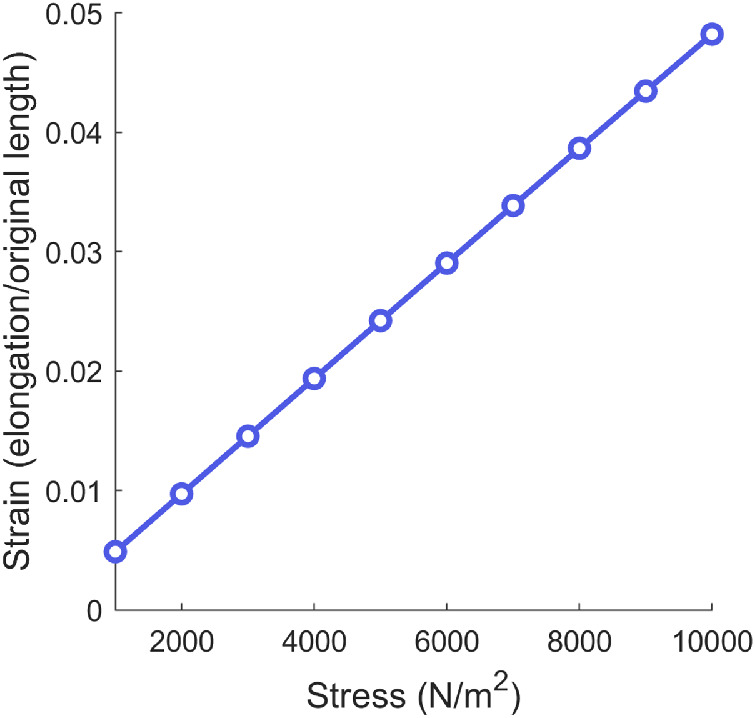
Stress-strain diagram for a cube from our experiment (elasticity = 0.5). As in the real world, there is a linear relationship between the amount of force applied and the lengthening of the material.